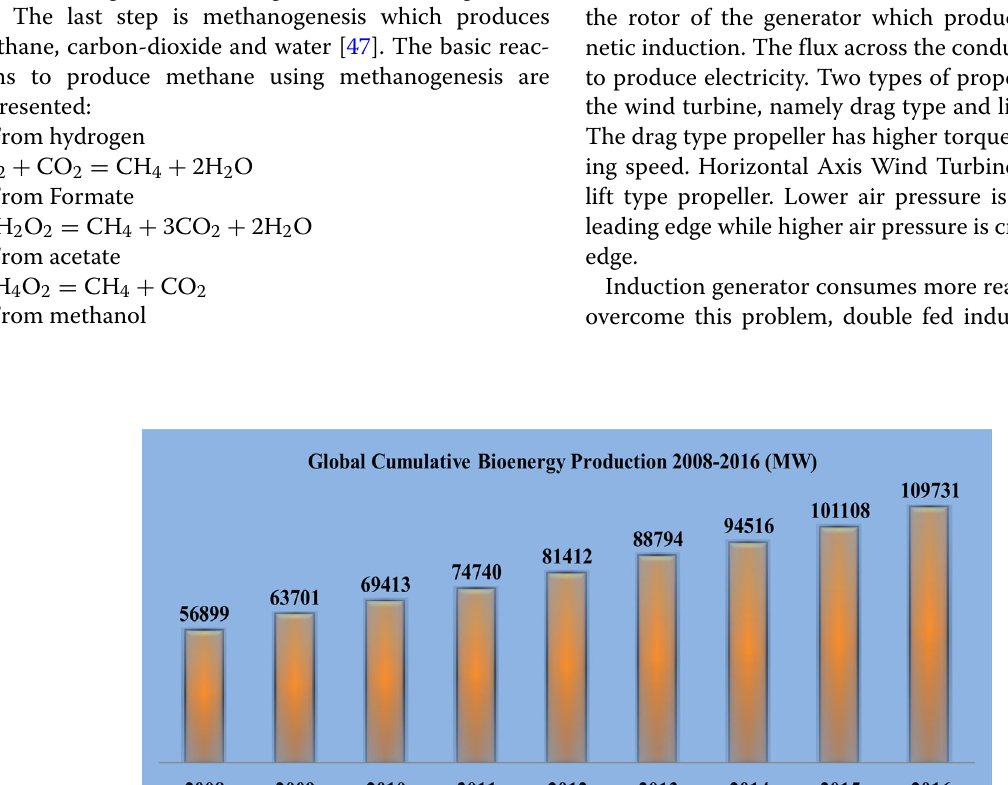
Figure 7 represents the basic block diagram for pro-